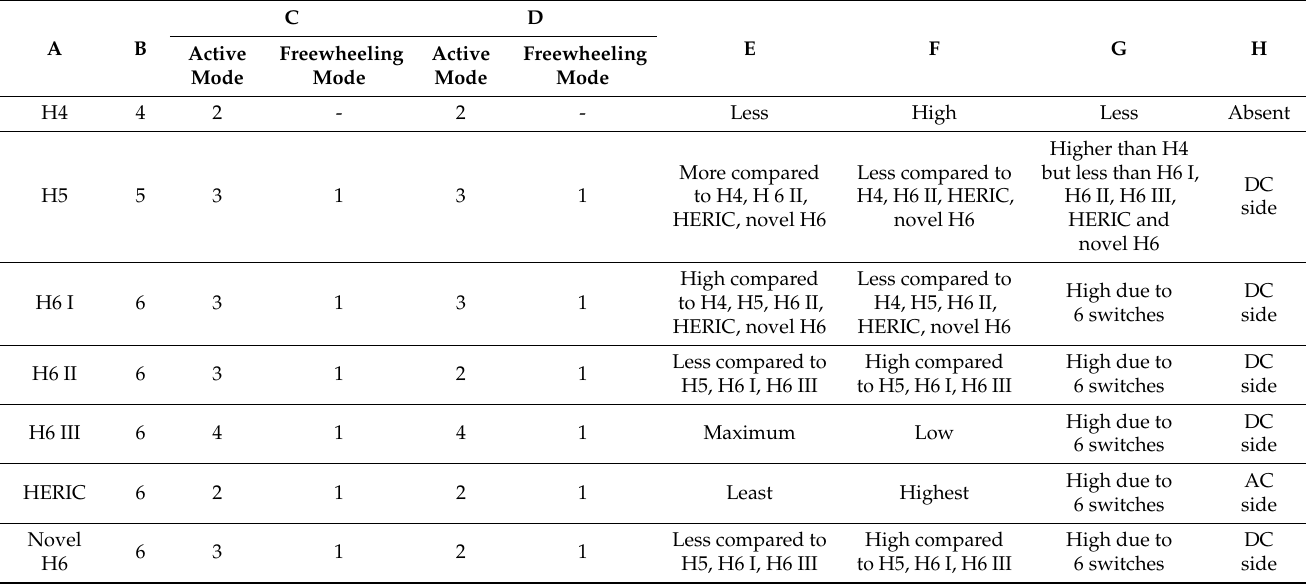
Table 2. Comparison of